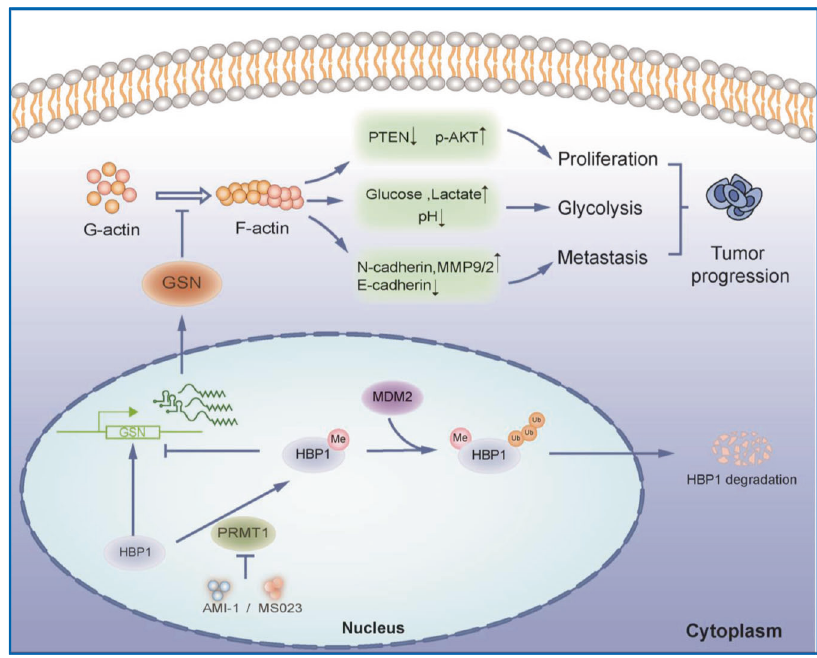
Fig. 8 Model of methylation HBP1 by PRMT1 regulating GSN-mediated actin cytoskeleton remodeling in tumor progress. HBP1 can be methylated by PRMT1 at R378. The methylation of HBP1 decreases the stability of HBP1 protein via accelerating its ubiquitination and proteasomal degradation, thereby reduces its transcriptional activation on GSN , downregulates GSN expression and leads to F-actin abnormally increasing. The excessive accumulation of F-actin promotes remodeling of the actin cytoskeleton and affects the metastasis and proliferation-related protein levels, and it will bring enormous impact on cancer cells malignant phenotype and promote tumor